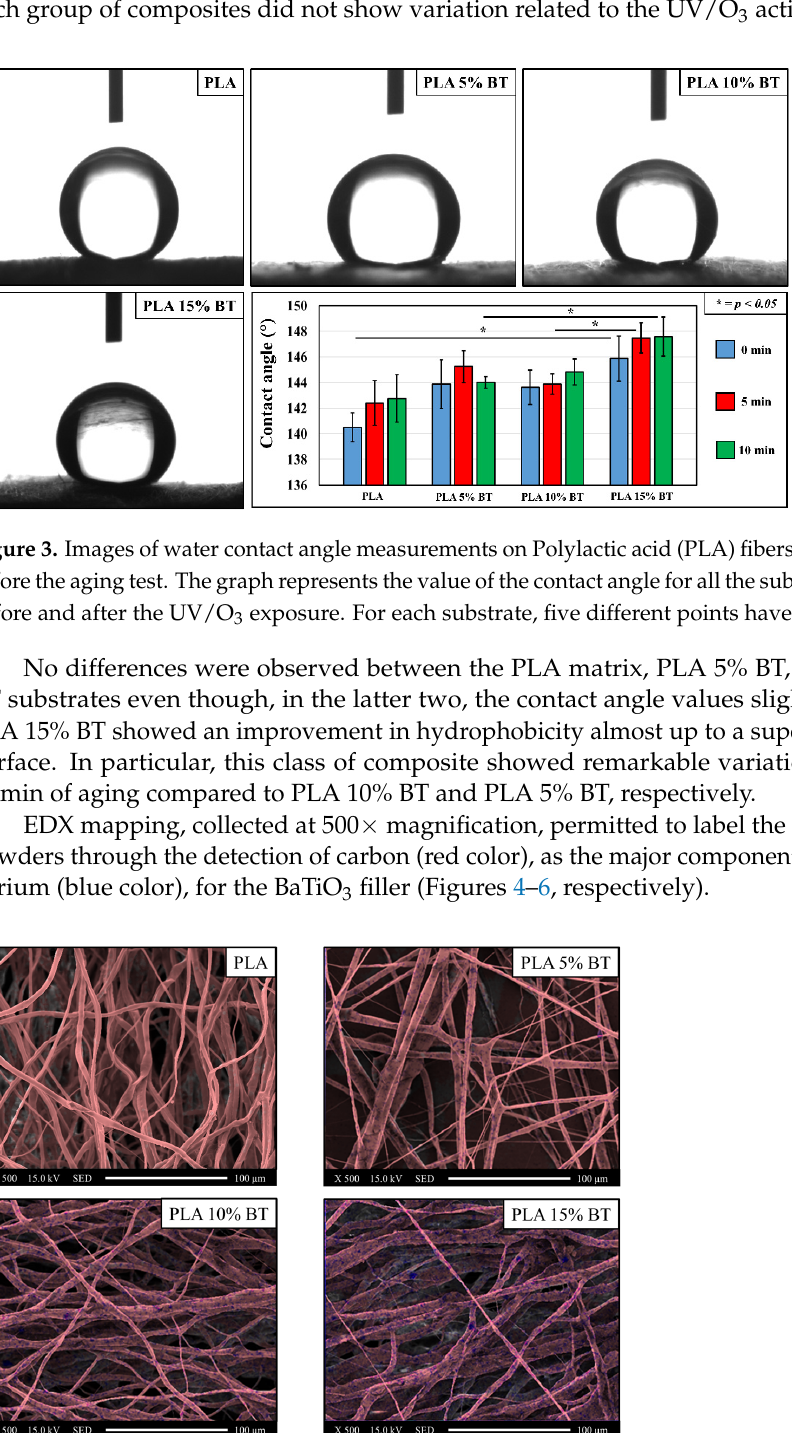
Figure 2. Comparison of roughness parameters, Ra and Rz of the substrates samples before and after treatment. The values are obtained by calculating the parameter in 25 images randomly acquired from each mapped surface using 150 ✕ of mag- nification.